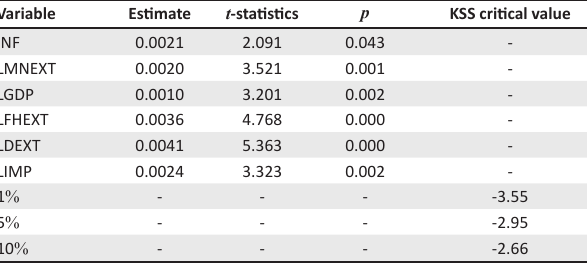
TABLE 4: Kapetanios, Shin, Shell test non-linear unit root results. Variable